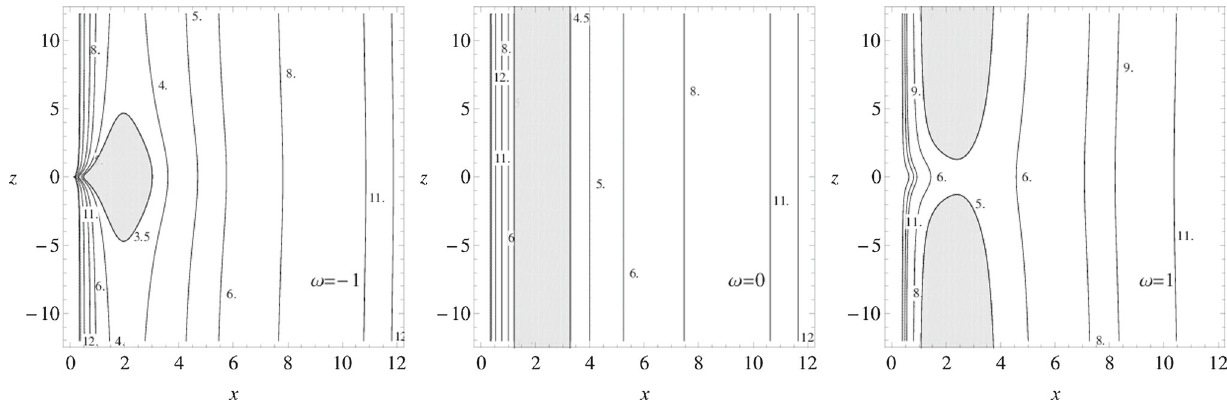
Fig. 1 The x and z sections of the effective potential V eff ( x , z ) for the flat spacetime. We use parameter J = 2 and we set Q = 0 . 9. Dashed curves correspond to the ω = 1 case, solid to the ω = 0, thick to the